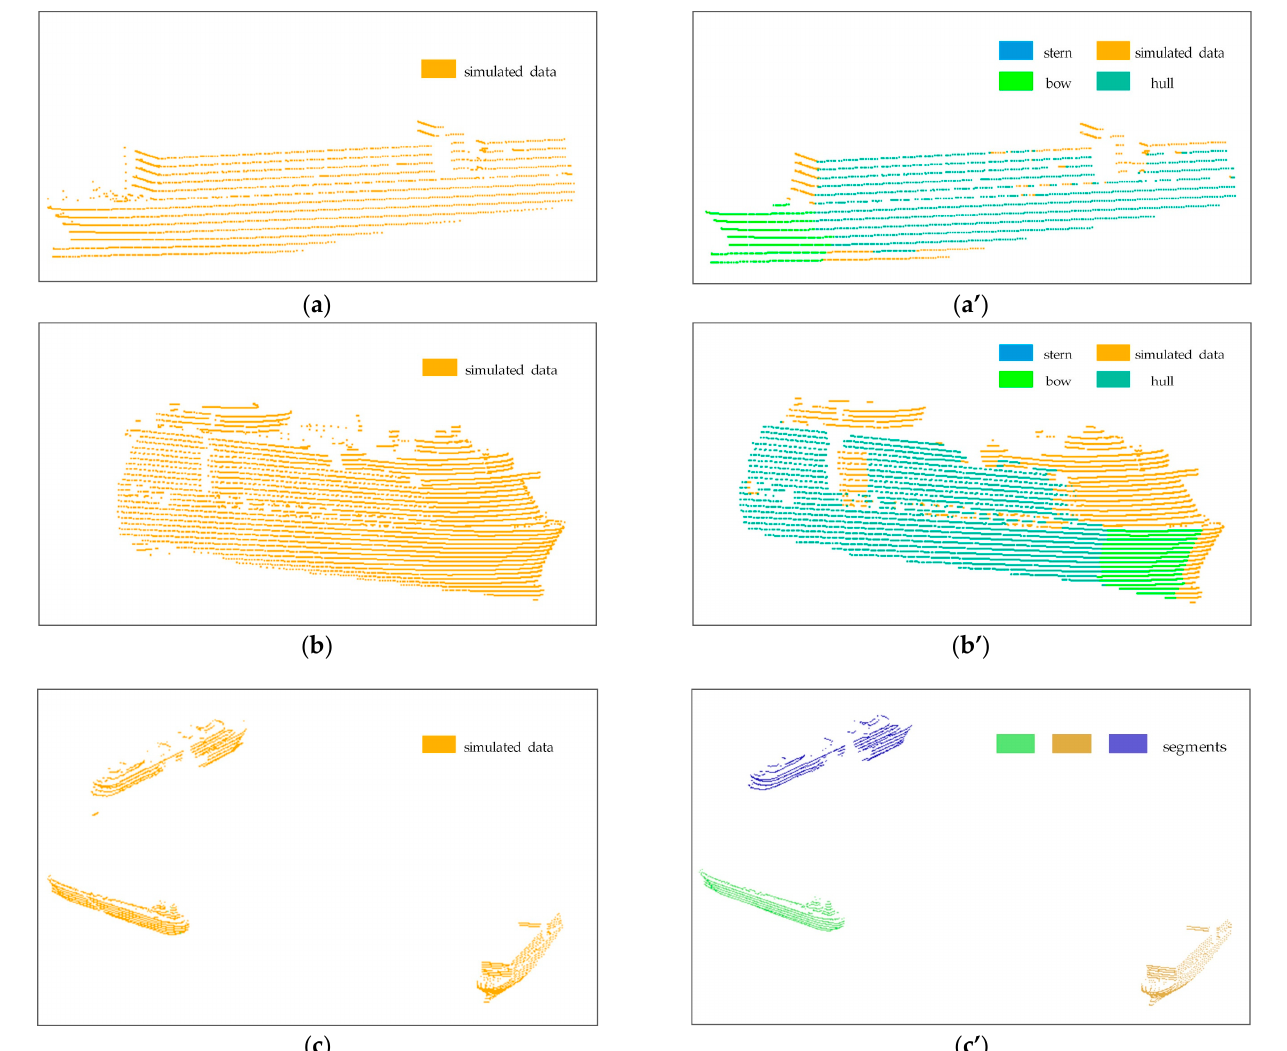
Figure 15. Verification of algorithm robustness through simulated data: ( a , b ): the simulated data of changed size and